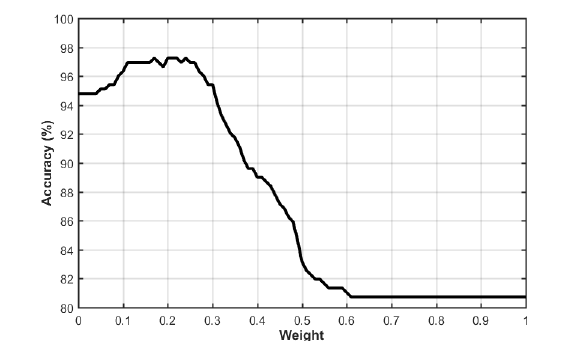
Figure 7. Change in performance according to weight values.